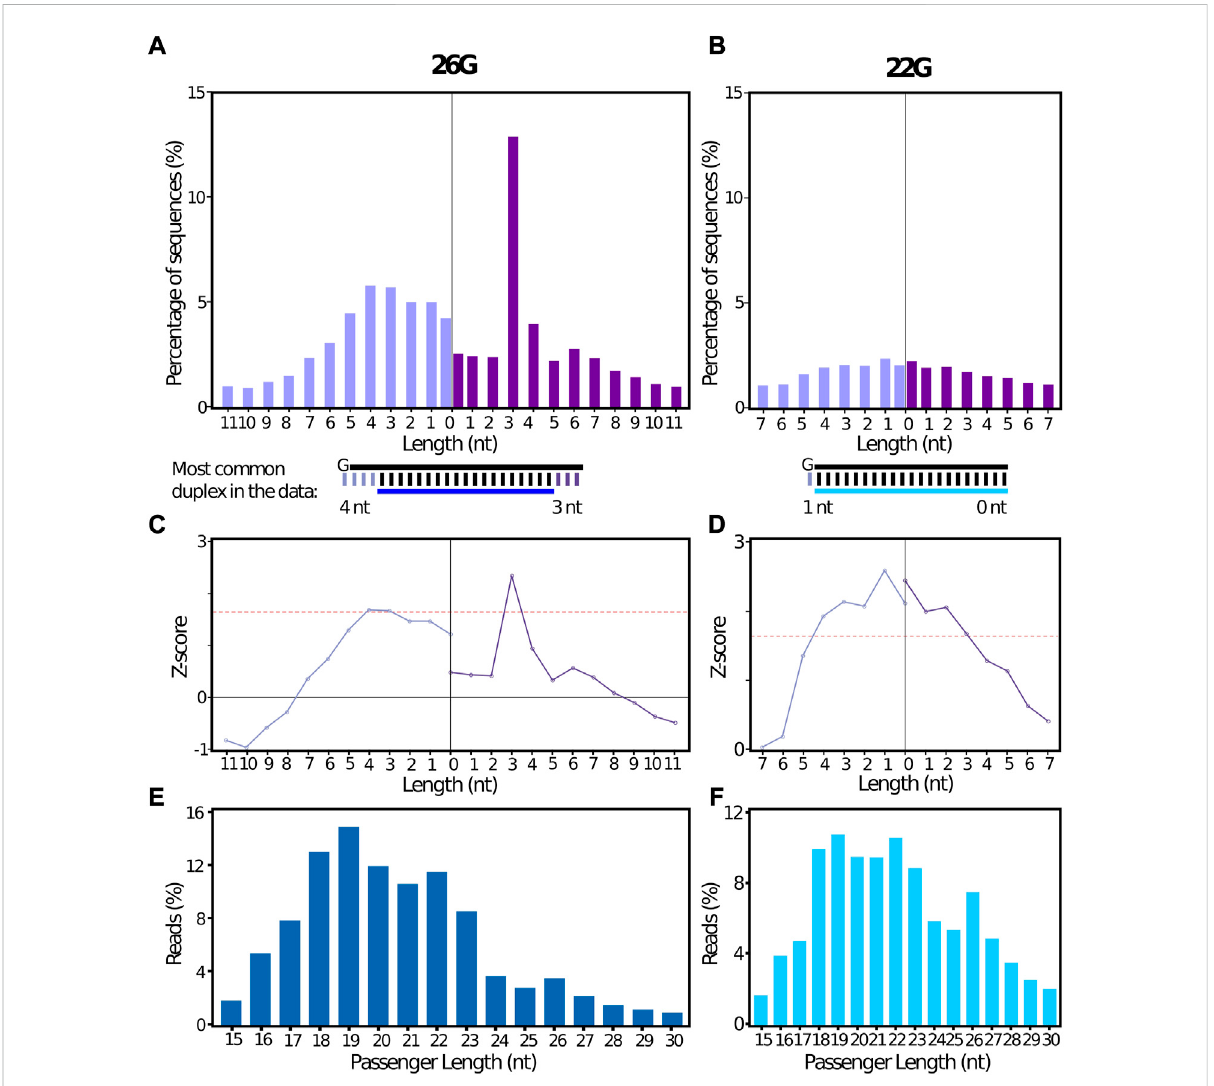
FIGURE 3 stepRNAidenti fi esDicercleavagesignaturesfromabiologicaldatasetcontaining C.elegans 26GsiRNAssequencedata.stepRNAwasrunusing acollapsed fi leofreferencesiRNAsreadsi.e.thatonlycontaineduniquesequencesthatareeither (A) 26 ntlongandstartwitha5 ′ guanine(26Gs;n= 28,651) or (B) 22 nt long and start with a 5 ′ guanine (22Gs; n = 106,723) (File A) against potential passenger sequences which include all siRNAs that are 15 – 30 nt long (File B). Sequence data was taken from (Fischer et al., 2011) (GEO: GSE32366). Bar graphs show the percentage of reference reads with a 3 ′ overhang (dark purple) or 3 ′ underhang (light purple), for (A) 26Gs and (B) 22G siRNAs. The most common siRNA duplex for 26G and 22G,aspredictedbystepRNA,isillustratedbelowtheplot.Linegraphsshowingthez-scoresfor (C) 26Gand (D) 22G.Redlineindicates p =0.05. Bar graphs show the predicted passenger length distribution produced by stepRNA for (E) 26G (dark blue) and (F) 22G siRNAs (light blue). In total, 22,003 and 49,059 passengers were predicted, for 26Gs and 22Gs respectively, by